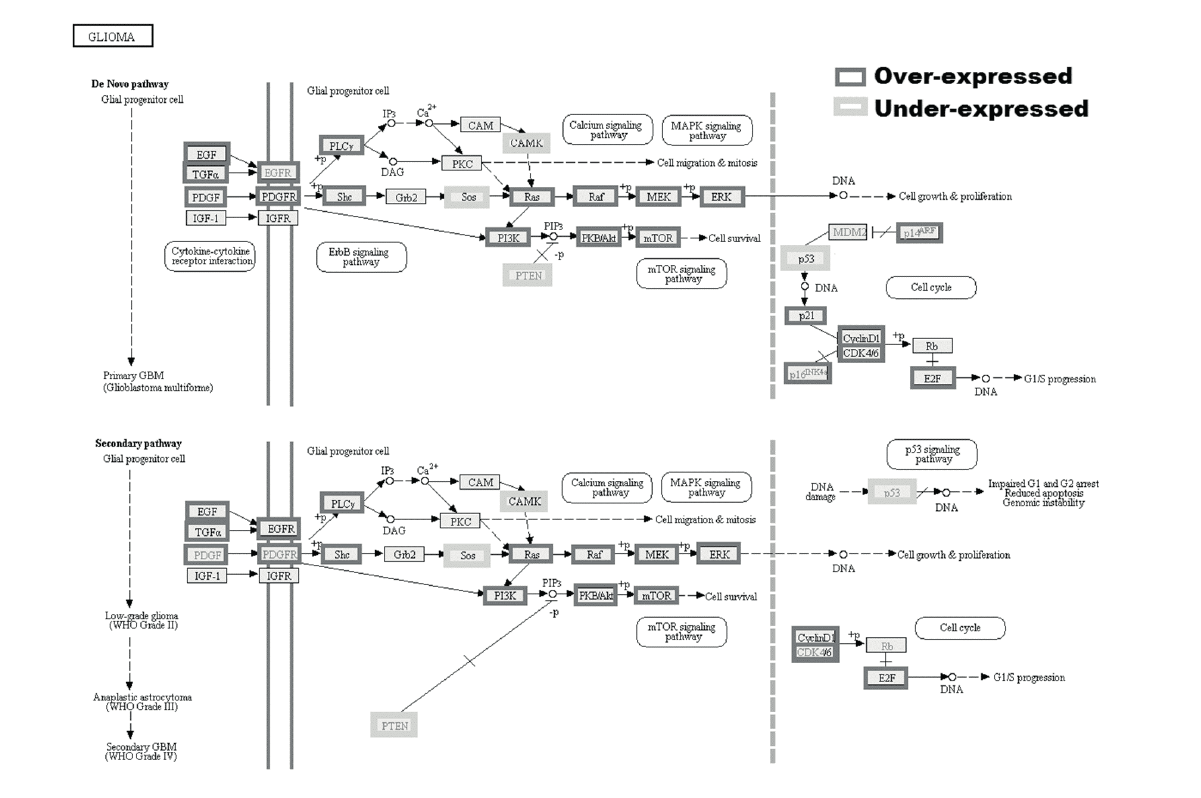
Fig. 4. Gene expression changes in glioma pathway. Key KEGG glioma pathway genes in our study. In this figure we have highlighted key KEGG glioma pathway genes (hsa: 04060) that were observed in pGBM. Upregulated genes (in red colored rectangles) and downregulated genes (in blue colored rectangles) from our study were highlighted in this figure. Genes that were not highlighted by colored rectangles were either absent or unchanged in our